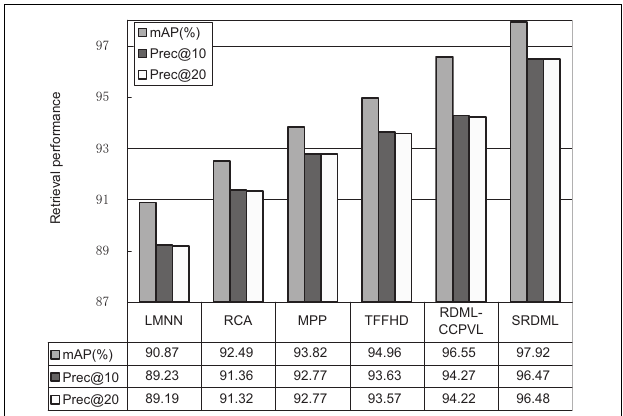
FIGURE 7 | Retrieval performance comparisons in Pituitary.